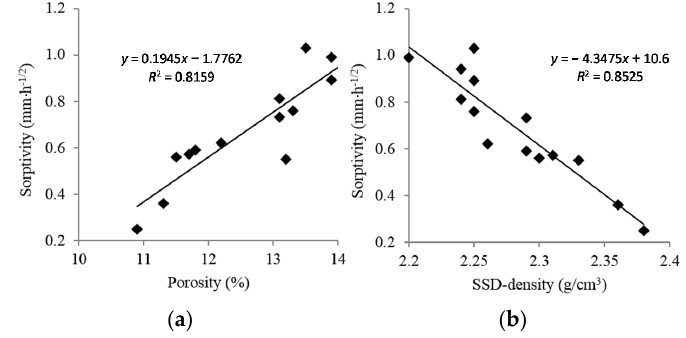
Figure 6. ( a ) Correlation between porosity with sorptivity. ( b ) Correlation between SSD density with sorptivity.